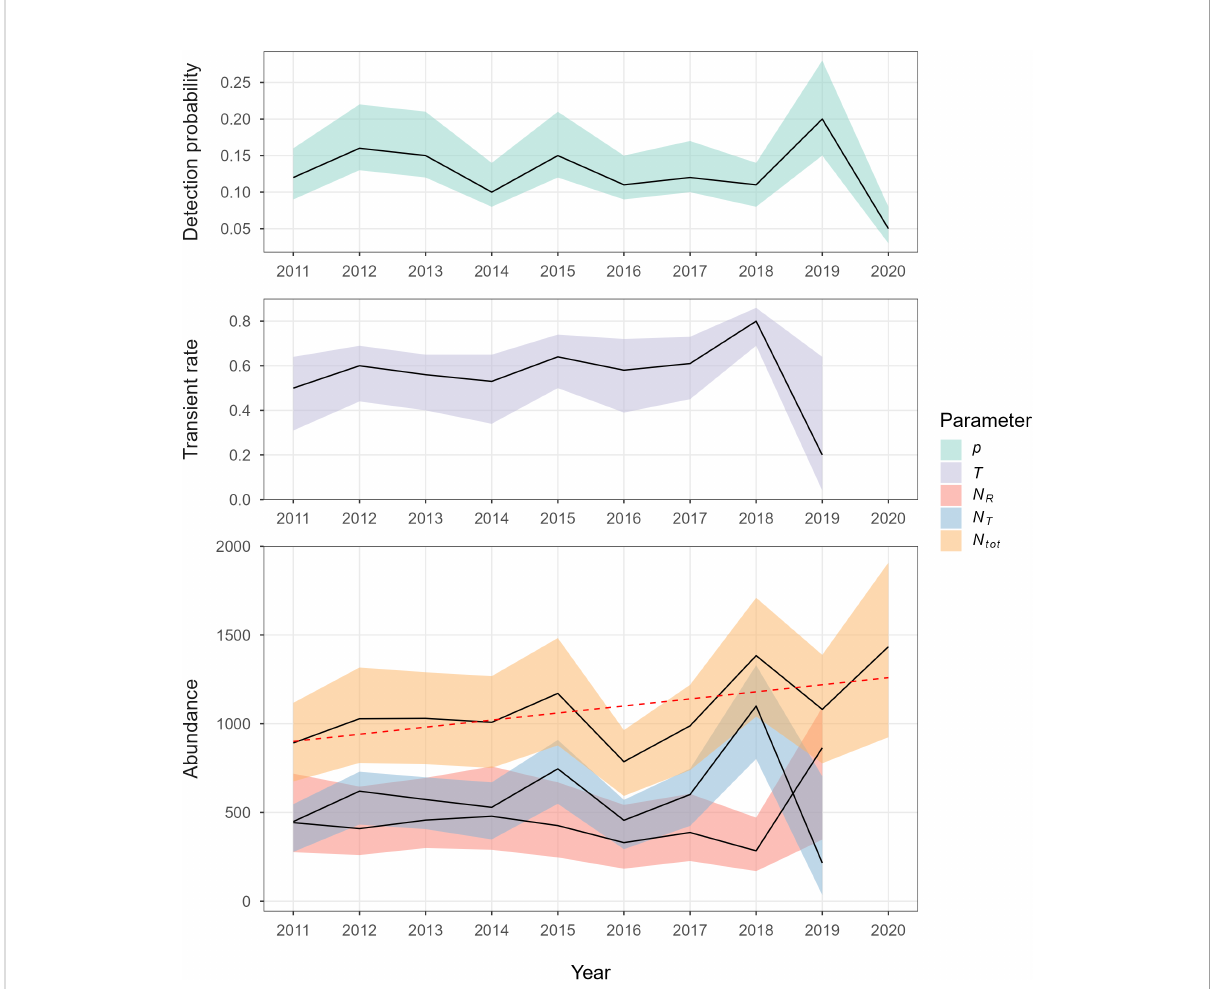
FIGURE 4 Annual estimates for detection probability ( p ), transient rate ( T ), abundance of non-transients ( N R ), abundance of transients ( N T ), and total abundance ( N tot ), with 95% con fi dence intervals (CI, shaded regions), for the best- fi tting model (effort-dependent p , transient F , time- dependent F 0 , constant F 1+ ). The weighted linear trend (non-signi fi cant) for total abundance is denoted by the dashed red